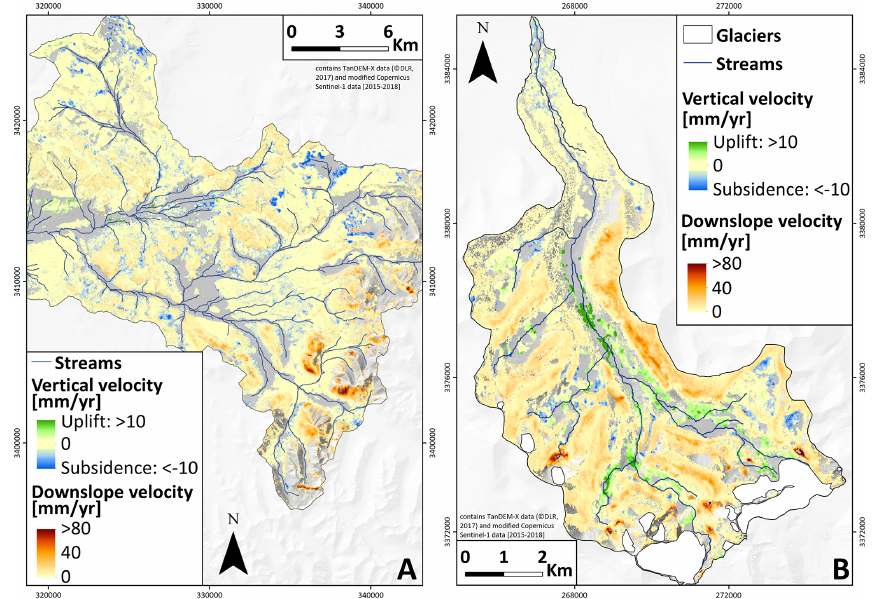
Figure 3. LVM of the Niyaqu (a) and Qugaqie (b) basins based on Sentinel-1 data (©Copernicus 2015–2018) over TanDEM-X DEM (©DLR, 2017). Flat terrain with a slope < 10 ◦ shows vertical velocity, and steeper terrain shows the surface velocity projected along the steepest slope. Maps showing the spatial distribution of flat and steep terrain are included in the Supplement.